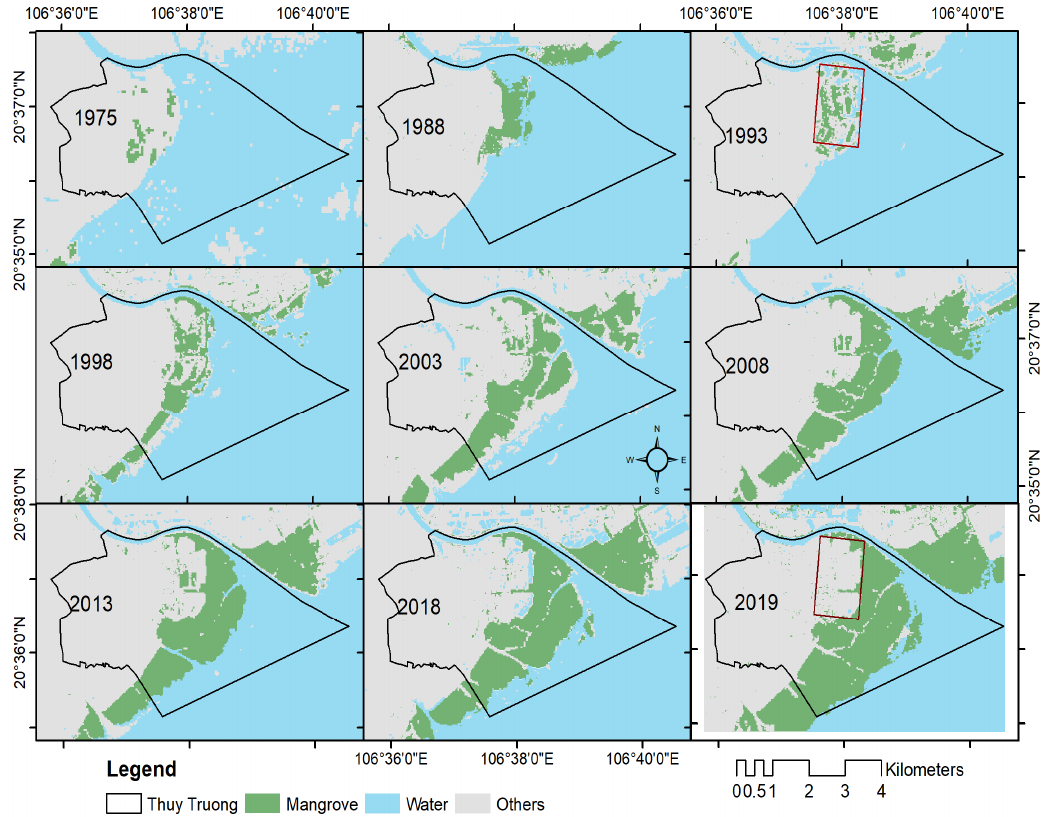
Figure 7. Changes in mangrove extent from 1975 to 2019 classified from a time series of Landsat images missions 2 to 8 (described in the Table 2) using the iterative self-organizing data analysis technique (ISODATA) classification, an unsupervised image classification approach (detailed in Section 2.3.1). The red rectangle denotes the same area of intensive aquaculture in 1993 and 2019.